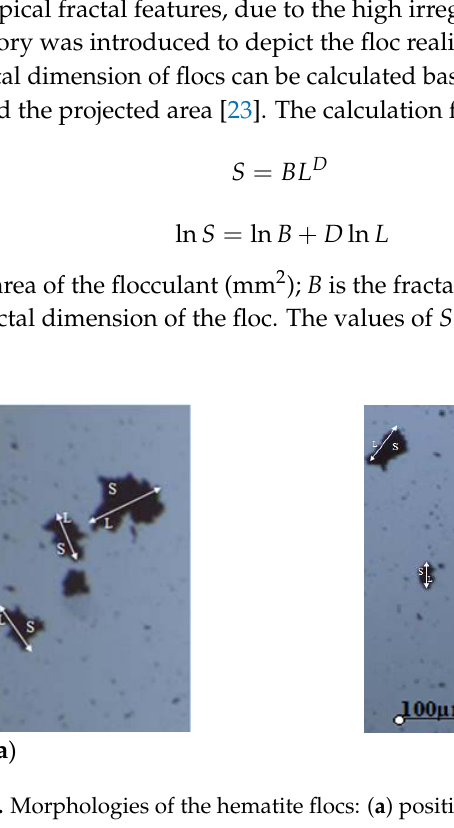
Figure 8. Morphologies of the hematite flocs: ( a ) position 1, ( b ) position 2.